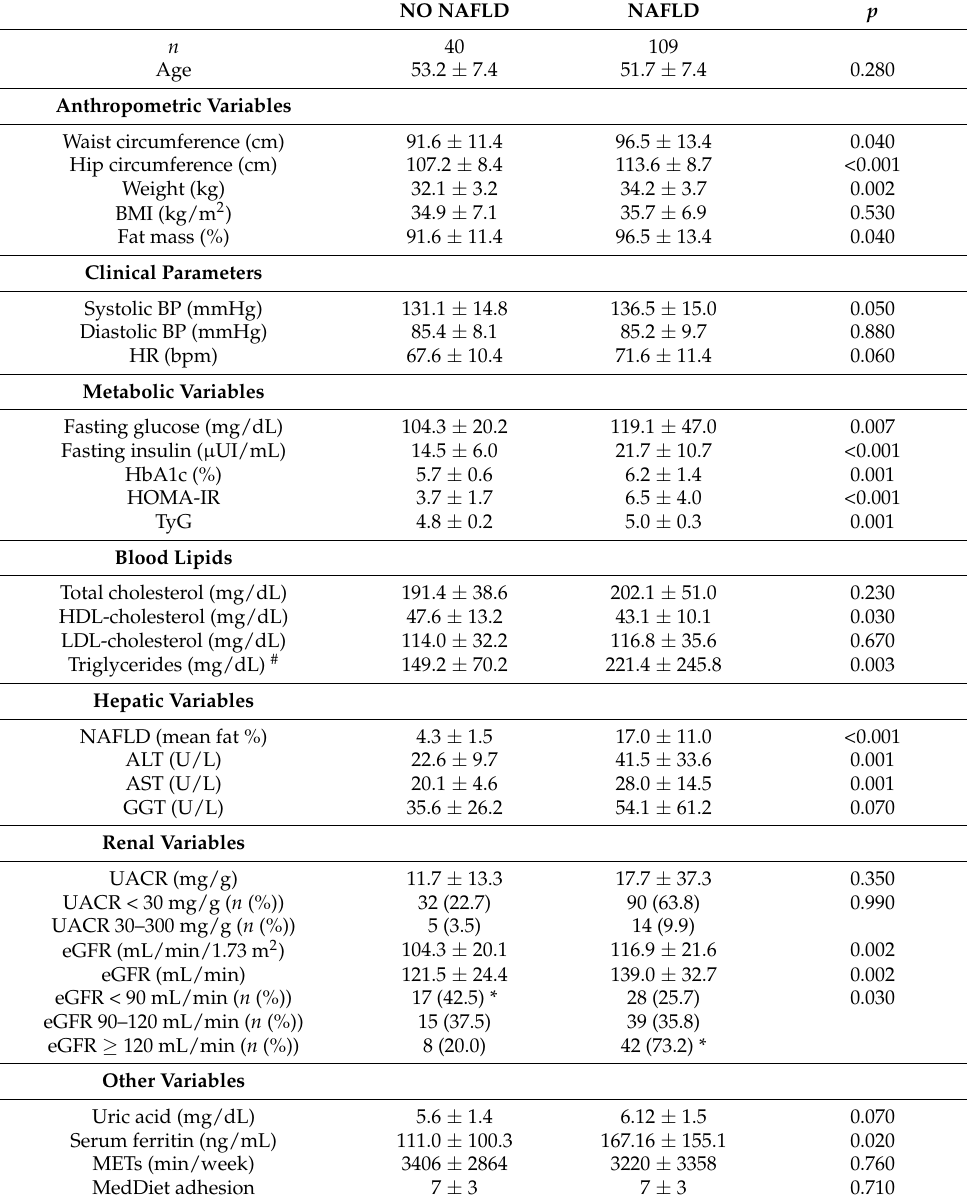
Table 2. Clinical and laboratory characteristics of the study population according to presence/absence of